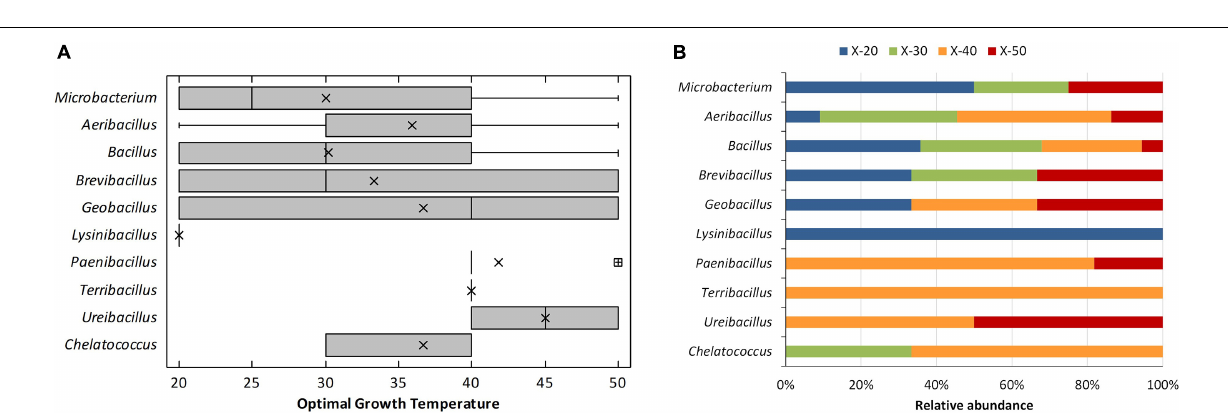
FIGURE 2 | Optimal growth temperatures of the thermophilic xylanolytic bacterial genus isolated from compost. (A) Box-and-whisker plot summarizing the range of optimal growth temperature for the different strains of each genus; mean values (x), median (I), and outliers ( (cid:3) ) are represented; (B) relative abundance of xylanolytic strains for each genus having the optimal growth temperature: 20 ◦ C (X-20), 30 ◦ C (X-30), 40 ◦ C (X-40), and 50 ◦ C